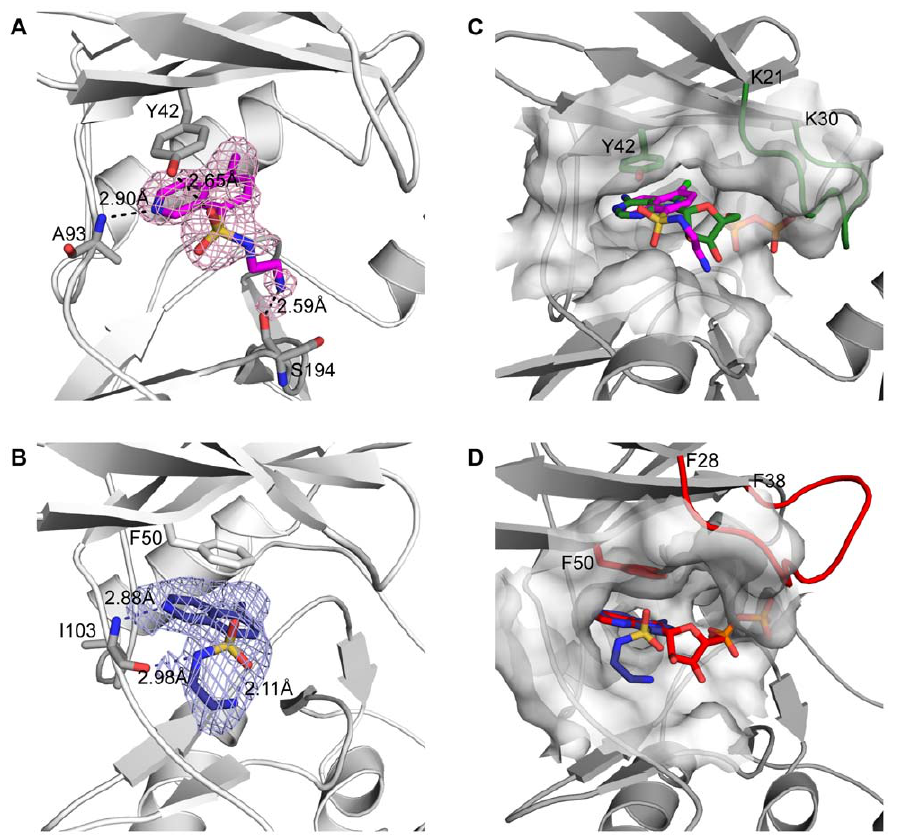
Figure 2. Nucleotide/inhibitor binding sites of APH(3 9 )-IIIa and APH(9)-Ia. The CKI-7- and nucleotide-bound APH(3 9 )-IIIa are shown in cartoon representation in panels A and C respectively; The CKI-7- and nucleotide-bound APH(9)-Ia are shown in cartoon representation in panels B and D, respectively. (A) CKI-7 bound to APH(3 9 )-IIIa in magenta sticks and its simulated annealing F o -F c omit map, contoured at 2.5 s , are shown. Tyr42, which forms stacking interactions with the isoquinoline, and Ala93, which hydrogen bonds with the inhibitor, are shown in sticks. (B) CKI-7 bound to APH(9)-Ia in dark blue sticks and its simulated annealing F o -F c omit map, contoured at 2.5 s , are shown. Phe50 whose aromatic ring stacks with the isoquinoline, and Ile103, which forms hydrogen bond interactions with the inhibitor, are shown in sticks. (C,D) Comparison of the inhibitor- and nucleotide-bound APHs. The homologous ePK gly-rich loop is highlighted in green for nucleotide-bound APH(3 9 )-IIIa (C) and red for APH(9)-Ia (D). Tyr42 in APH(3 9 )-IIIa and Phe50 in APH(9)-Ia, that stacks the adenine ring of the nucleotide are shown in sticks and their carbon atoms are colored green for APH(3 9 )-IIIa (C) and red for APH(9)-Ia (D). The CKI-7-binding sites are delineated by surface representation in their respective enzymes. CKI-7 bound to APH(3 9 )-IIIa and APH(9)-Ia are colored as in panels A and B. CKI-7 binds to the same region and in an analogous manner as the nucleotide to each of the enzyme. The phosphates of the nucleotide are buried in the surface representing the homologous gly-rich loop in the presence of CKI-7.